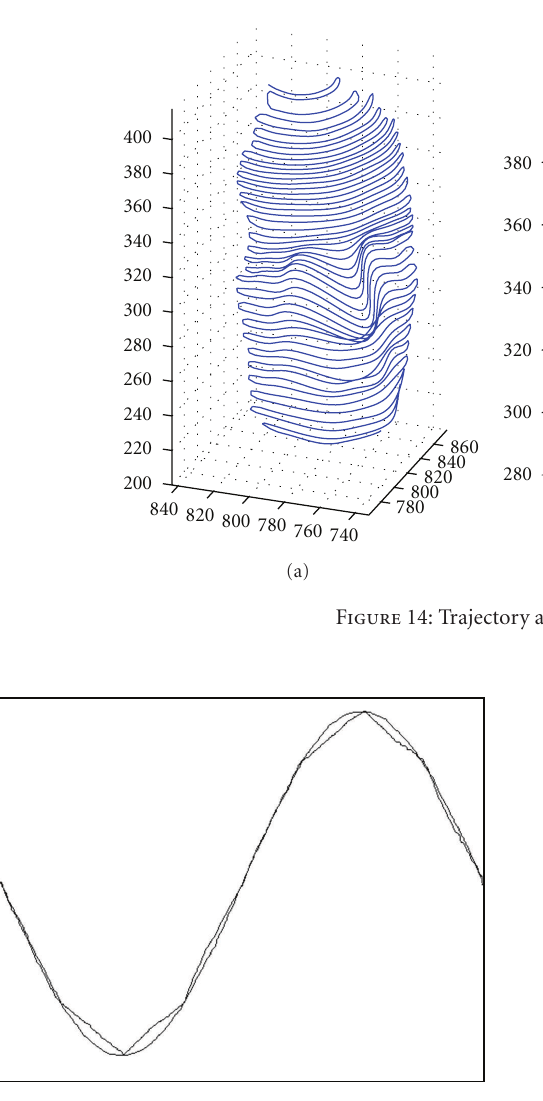
Figure 15: Comparison between point-to-point planning and posi- tion and velocities